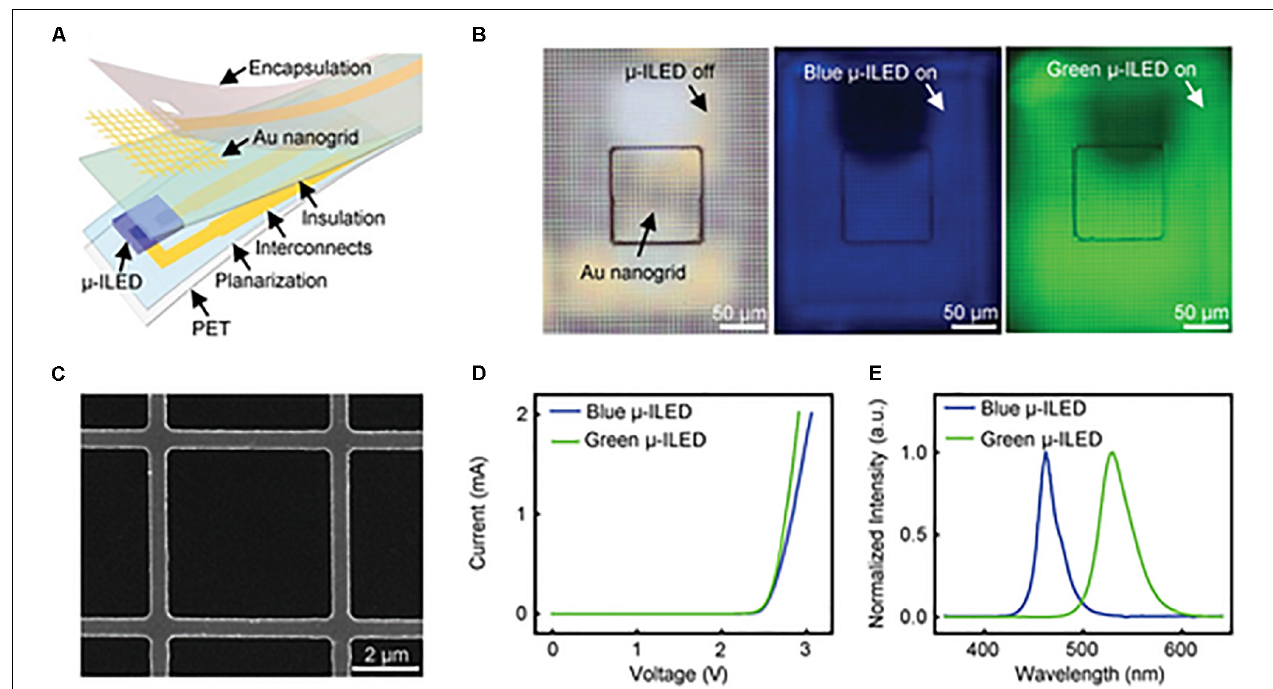
FIGURE 3 | Gold optoelectronic devices for simultaneous optical modulation and electrophysiology possess superior properties including low electrical impedance, high transparency, good cell viability, and superb flexibility. (A) Exploded illustration of a multifunctional optoelectronic device containing a transparent gold nanogrid electrode directly on top of a µ -ILED. (B) Optical images of a device with µ -ILED turned off (left) and a blue (middle) and green (right) µ -ILED turned on. (C) SEM image of a representative Au nanogrid electrode with a width at 500 nm and a line spacing at 5 µ m. (D) Current and voltage characteristics of the blue and green µ -ILEDs. (E) Normalized emission spectra of the blue and green µ -ILEDs. Reproduced from Obaid et al.